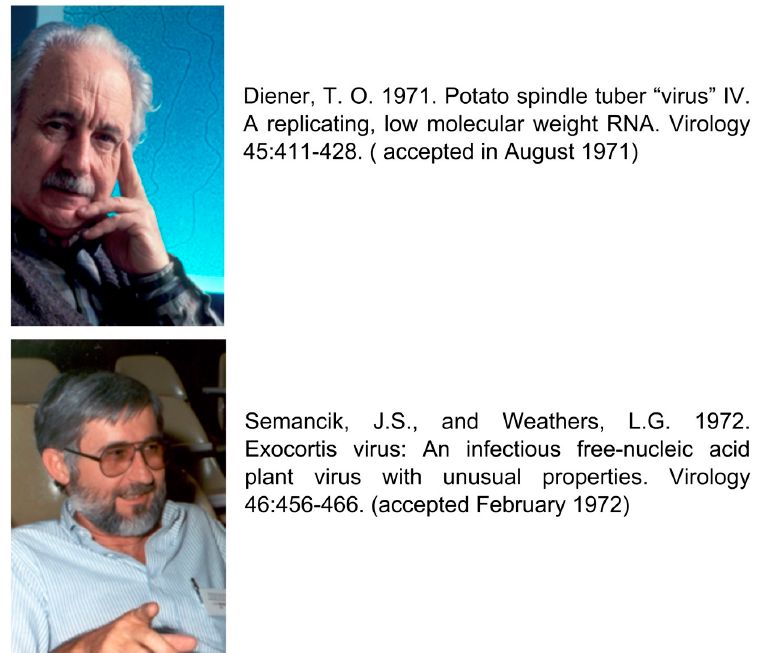
Figure 5. The two scientists responsible for the early discovery/characterization of viroids as disease-causing agents and their conflictive publication.